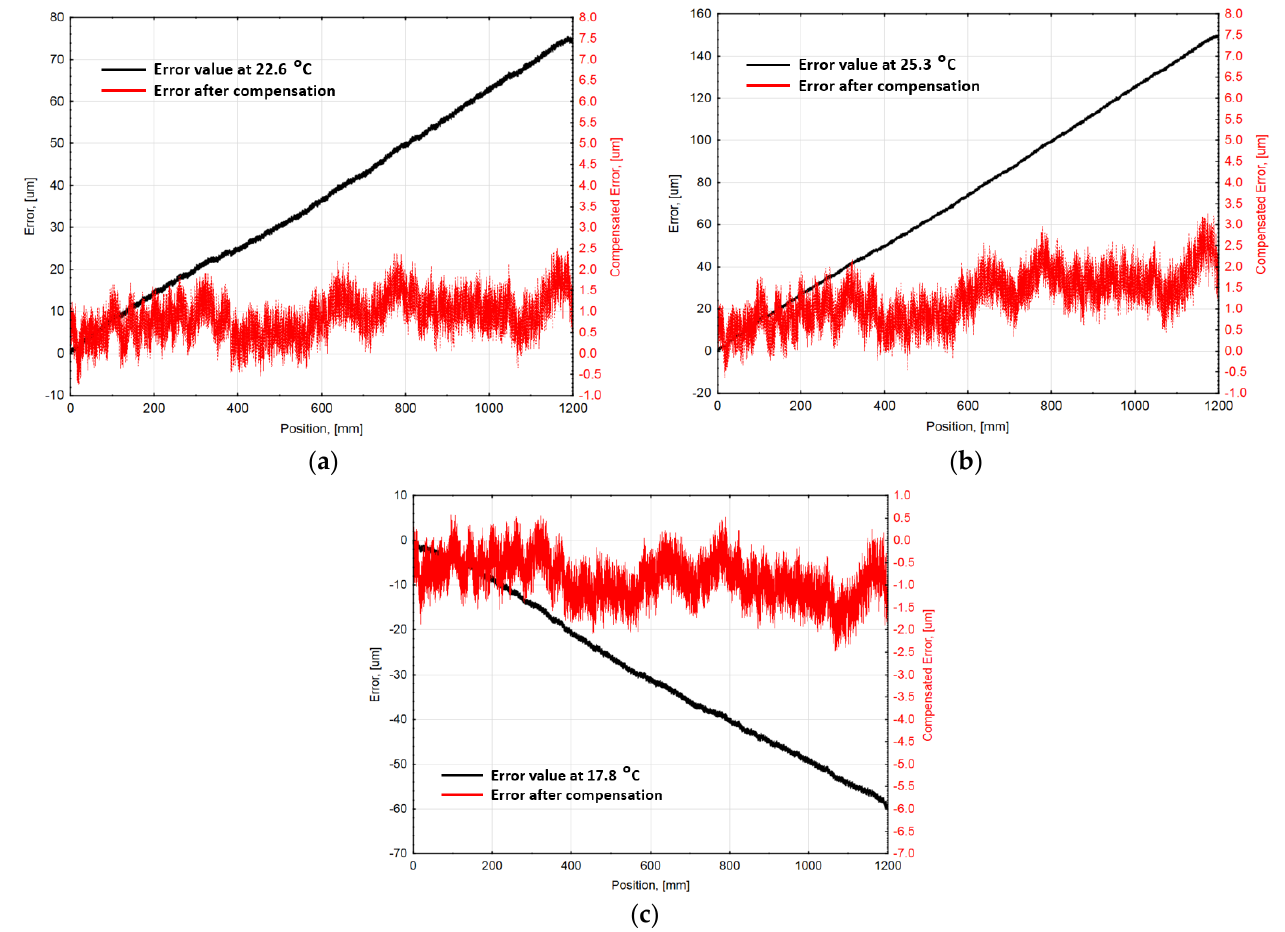
Figure 8. Compensated linear encoder average accuracy graphs (red line/right Y-axis units) with corresponding uncompensated error values (black line/left Y-axis units), at different ambient temperatures: ( a ) at 22.6 °C; ( b ) at 25.3 °C; and ( c ) at 17.8 °C.